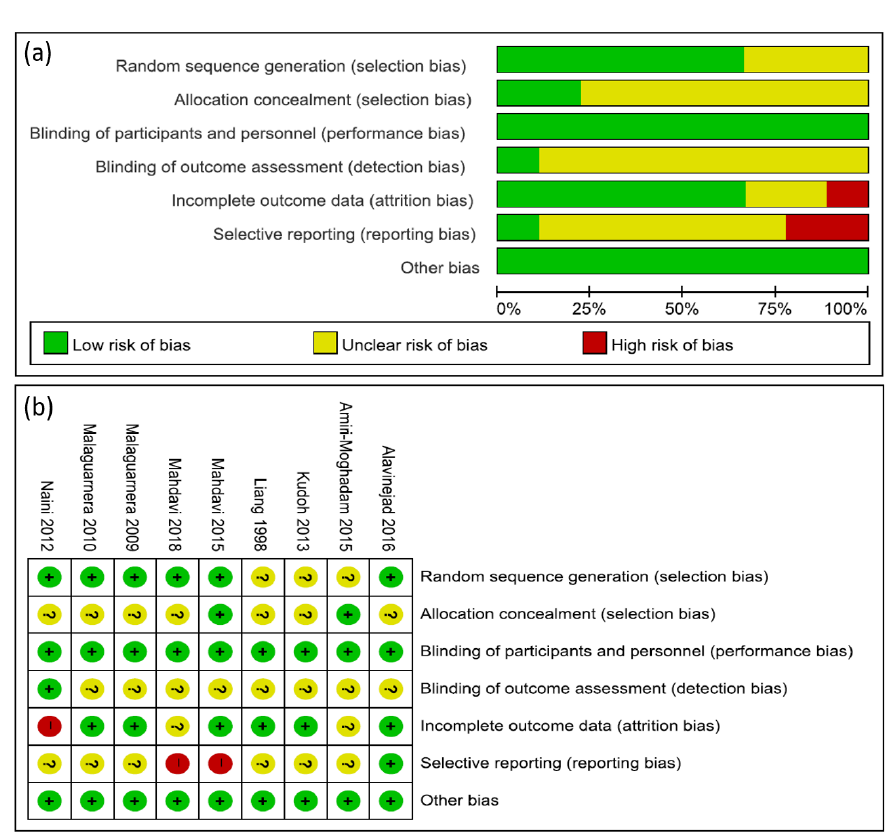
Figure 2. Risk of bias graph ( a ) and bias summary ( b ). Risk of bias levels: low (green or “+”), Unclear (yellow or “?”), High (red or “-“)